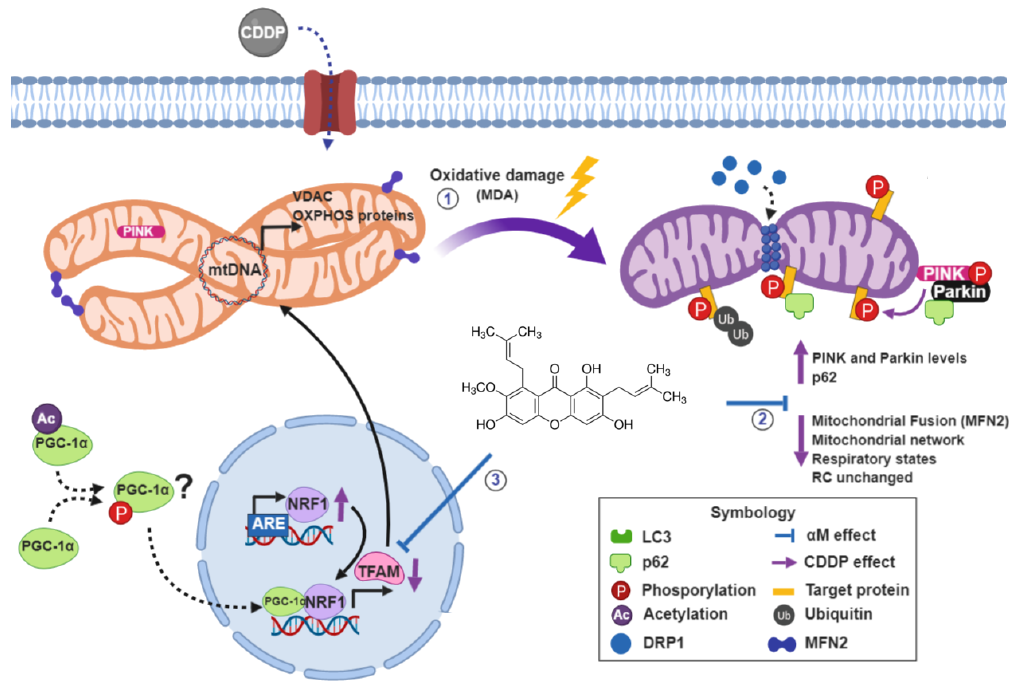
Figure 11. Integrative scheme. CDDP induces (1) the increase MDA level, (2) decrease respiratory states (except respiratory control, RC), the mitochondrial network fragmentation, the mitochondrial fusion protein 2 (MNF2) decrease and induce mitophagy (PINK1 / Parkin and p62 increase). Furthermore, CDDP induces (3) TFAM reduction which reduces mitochondrial protein (VDAC and OXPHOS) and probably mitochondrial transcription, and also induces an NRF1 increase. The α M prevented all alterations, except NRF1 induction. Created with BioRender.com.